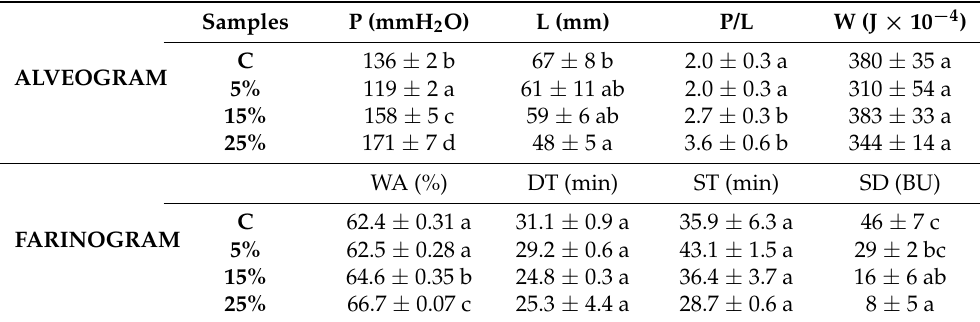
Table 2. Alveographic and farinographic parameters of wheat flour (control: C) and blends of wheat flour and oat flour at levels of 5, 15, and